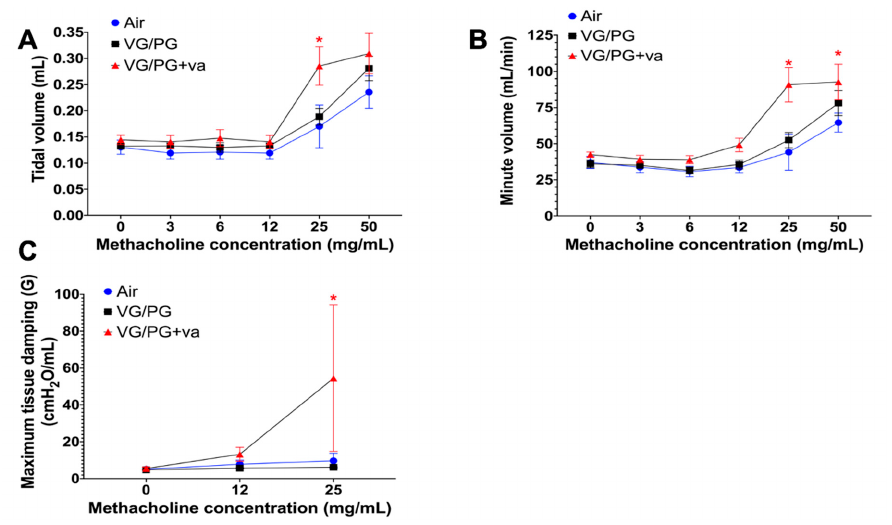
Figure 1. Inhalation of e-cig aerosol composed of 70%/30% VG/PG plus vanilla flavor impairs lung function. Whole-body plethysmography with methacholine challenge was used to determine tidal volume ( A ), and minute volume ( B ) ( n = 8 per group), while the flexiVent ® system was used to assess the maximum tissue damping ( C ) ( n = 6 per group). Data are expressed as mean ± standard error of the mean (SEM). Differences were analyzed by a two-way ANOVA. * p < 0.05.